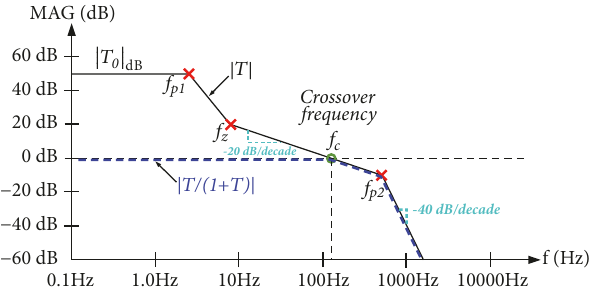
Figure 8: Illustration of magnitude asymptote of desired loop gain 𝑇(𝑠)|